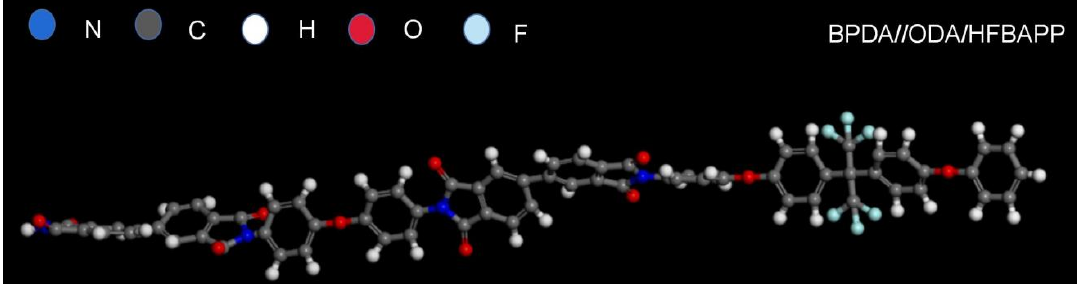
Figure 3. An example of models used for simulation: BPDA//ODA/HFBAPP.